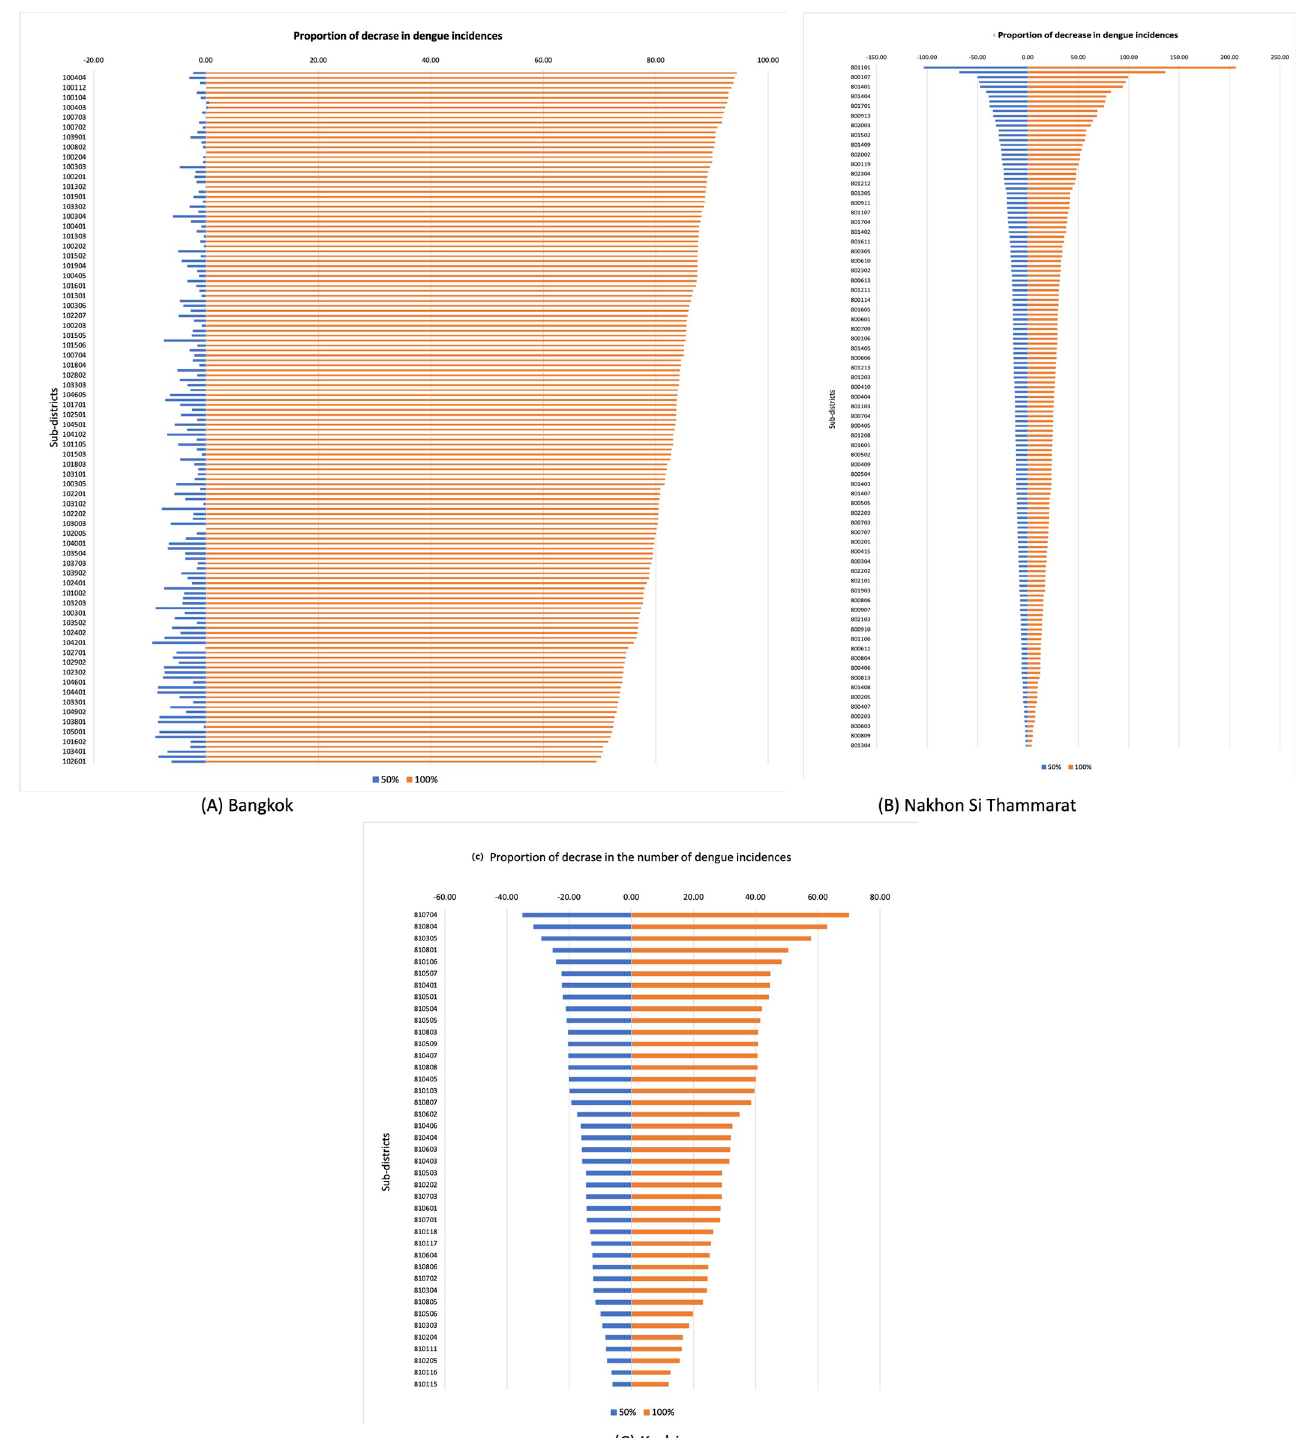
Fig 8. The proportion of decrease in dengue cases in (A) Bangkok, (B) Nakhon Si Thammarat, (C) Krabi province.